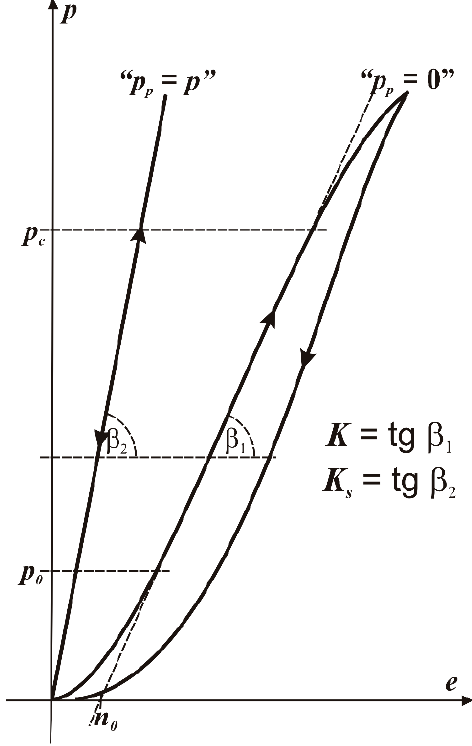
Figure 2. Typical compressibility curves (the arrows on the curves indicate the direction of pressure changes): K , K s —compressibility moduli, p 0 , n 0 —crack closing pressure and crack porosity, respectively ([10]), p C —pressure of rock consolidation; reproduced from [10], Arch. Min. Sci.: 1989.